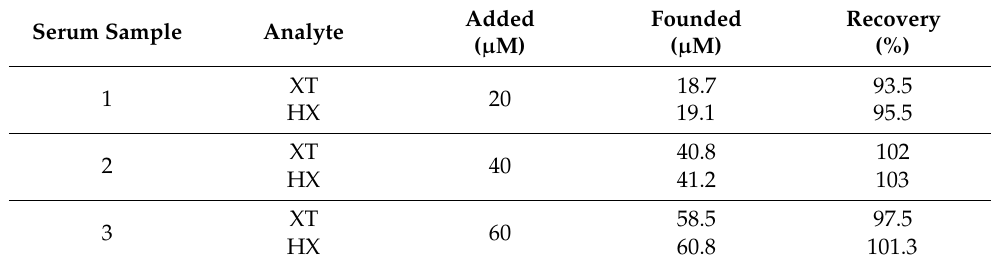
Table 2. Simultaneous determination performance of p-Gly/rGO/GCE in human blood serum. Serum Sample